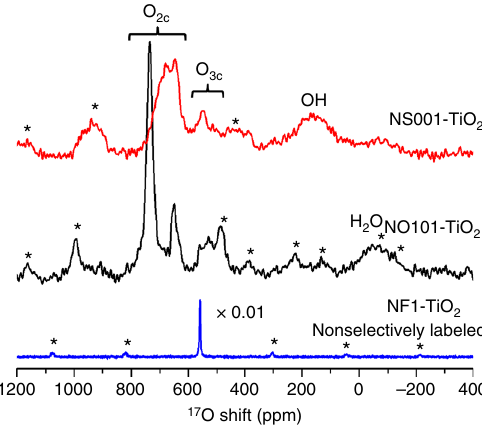
Fig. 1 17 O NMR spectra of faceted anatase titania nanocrystals compared to the non-faceted sample. Anatase TiO 2 nanosheets with dominant exposed (001) facets (NS001-TiO 2 ), and nano-octahedra preferentially exposing (101) facets (NO101-TiO 2 ) were surface-selectively 17 O-labeled and vacuum dried for 2 and 12 h, respectively. The other sample, NF1-TiO 2 , was nonselectively 17 O-labeled. All data were obtained at 9.4 T under a MAS frequency of 14 kHz. A rotor synchronized Hahn-echo sequence ( π /6 − τ − π /3 − τ — acquisition) and optimized recycle delays (0.5 s for NS001-TiO 2 and NO101-TiO 2 , and 50 s for NF1-TiO 2 , see Supplementary Fig. 8), with 1 H decoupling, were used to obtain the NMR data. 120,000, 110,000, and 1200 scans were collected for NS001-TiO 2 , NO101-TiO 2 , and NF1-TiO 2 , respectively. The spectra are normalized according to the sample mass and the number of scans (Supplementary Table 4). Asterisks denote sidebands. The dependence of the 17 O MAS NMR spectra of the two faceted samples on the vacuum-drying time is shown in Supplementary Figs. 9 and 10, and discussed in the Supplementary Notes 2 and